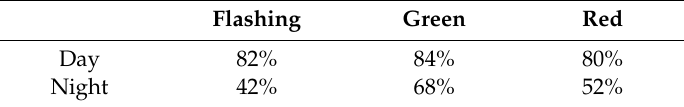
Table 3. Accuracy measurement for crosswalk safety guidance.